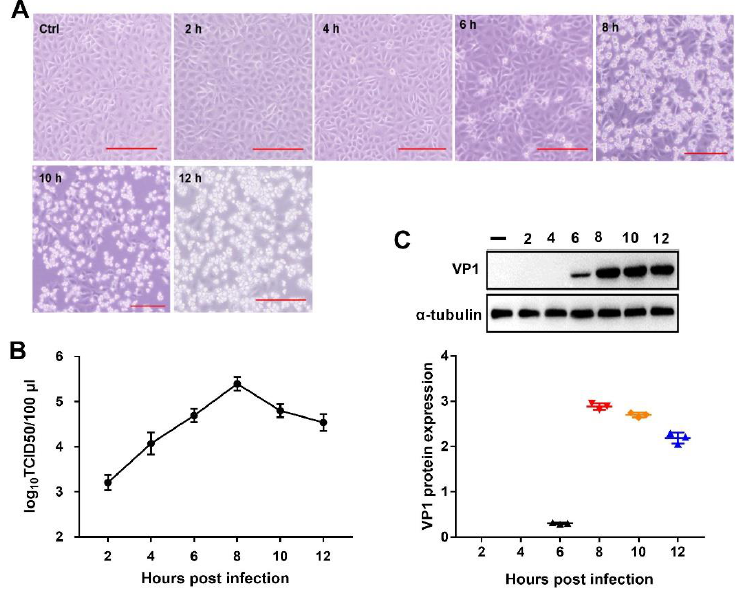
Figure 1. Sapelovirus A (PSV) infection in pig kidney (PK)-15 cells. ( A ) PK-15 cells were mock-treated or treated with PSV at a multiplicity of infection (MOI) of 2, and the cytopathogenic e ff ects at indicated time were observed. Bars, 50 µ m. ( B ) One-step growth curve of PSV in PK-15 cells. ( C ) Western blotting assay of PSV virus protein (VP)1 expression in PK-15 cells at the indicated time points (2–12 h). The α -tubulin was used as a sample loading control. Data are expressed as mean ± SD for two independently